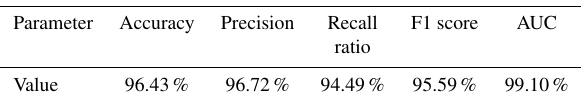
was executed by a combined usage of NVIDIA GeForce RTX 2080Ti × 4 GPU, with parallel computing management